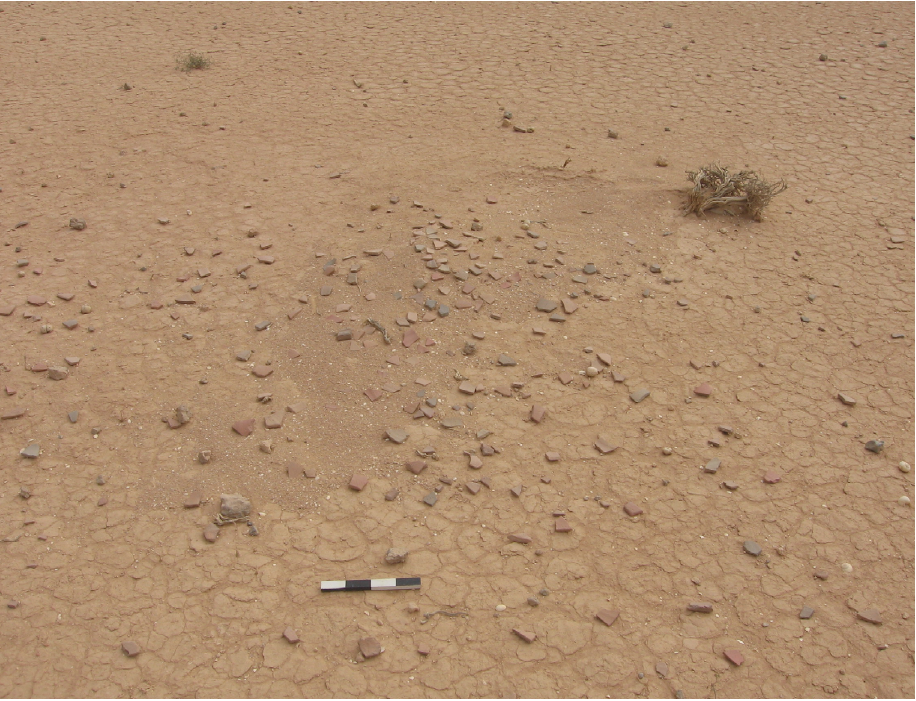
Fig. 10. Traces of human presence consisting of pottery fragments from Roman times (scale bar is 20 cm) and fire places, and the natural vegetation at Bir Abu Mukhayat (cf. Fig. 4). (Anna-Katharina Rieger).